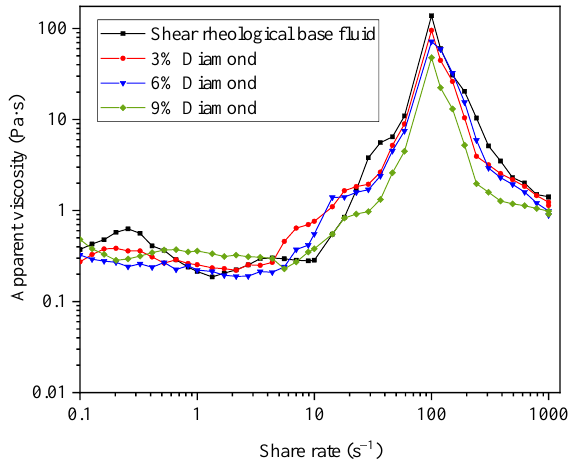
values of the region owing to the large sample area. The final experimental results were the average values of the four regions. Before and after polishing, the wafer quality was measured three times and averaged using a precision balance (MSA225S − CE, Sartorius, Germany, accuracy of 0.01 mg). The surface morphology of the wafer was observed using the ultradepth of a field microscope (VHX − 7000, Keyence, Japan) and a scanning electron microscope (Sigma − 300, Zeiss, Germany). Figure 3. Rheology curves.